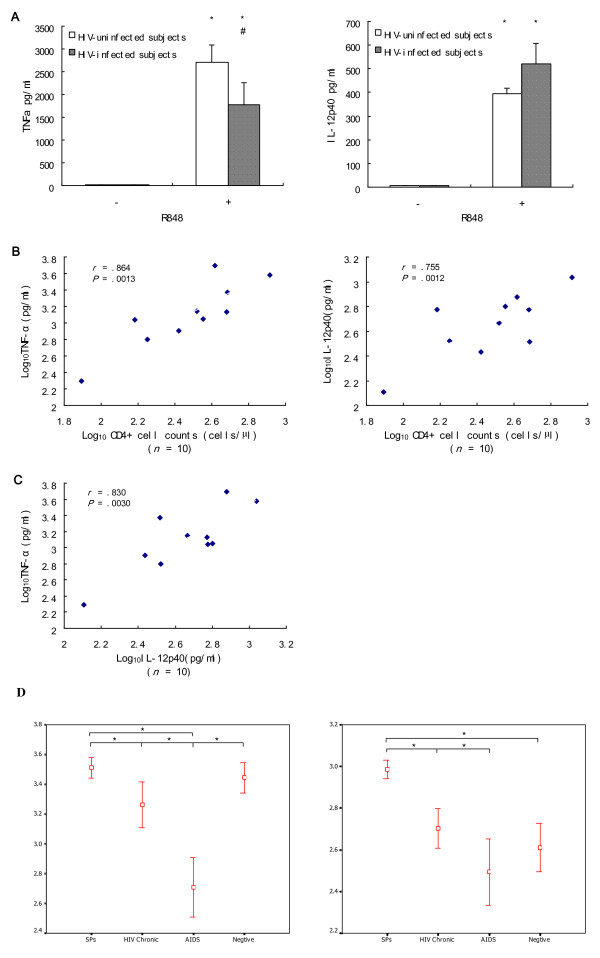
Proinflammatory cytokine secretion mediated by TLR7/8 in monocytes varied based on HIV-infection status and correlated positively with CD4+ cell counts of peripheral blood in HIV-infected subjects. Ex vivo monocytes from uninfected (n = 10) and HIV-infected (n = 10) subjects were cultured in the presence of TLR 7/8 ligand R-848 or media alone for 24 h. Culture supernatants were assessed for cytokine levels using an ELISA assay. (A) R-848 stimulation produced significantly greater TNF-α production in monocytes of both HIV-infected and uninfected subjects compared with unstimulated samples (p < 0.0001); stimulated uninfected subjects produced more TNF-α than stimulated HIV-infected subjects (p = 0.0412). R-848 also induced significantly greater IL-12p40 production in monocytes of both HIV-infected (p < 0.0001) and uninfected subjects compared with unstimulated monocytes (p < 0.0001). No statistically significant increase in IL-12p40 was observed in HIV-infected versus uninfected subjects (P = 0.198). TNF-α levels were analyzed using the Mann-Whitney U two-tailed test. Independent t test were used to analyze IL-12p40 levels. The significant differences are represented as p value (* p < 0.0001 compared with unstimulated by R-848, # p = 0.0412 compared with uninfected subjects). All data are expressed as the mean ± SEM values from experiments performed in triplicate. (B) Levels of TNF-α and IL-12p40 secreted by monocytes via TLR7/8 were significantly correlated with CD4+ cell counts in the ten HIV-infected individuals. (C) TNF-α exhibited a significant positive correlation with IL-12p40 in HIV-infected individuals. Data was analyzed using a Pearson correlation. Experiments were repeated at least 2 times with similar results. (D) The level of TNF-α and IL-12p40 secretions of triggered monocytes derived from 31 subjects belonging to the four categories (7 subjects of SPs, 10 of HIV Chronic, 7 of AIDS and 7 of Negative) were described (*p < 0.05).